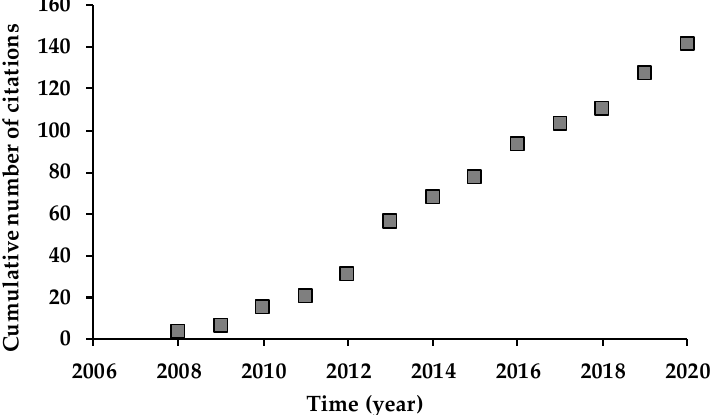
Figure 1. Cumulative number of citations on works reporting the activity of essential oils against pitch canker fungus ( Fusarium circinatum ).